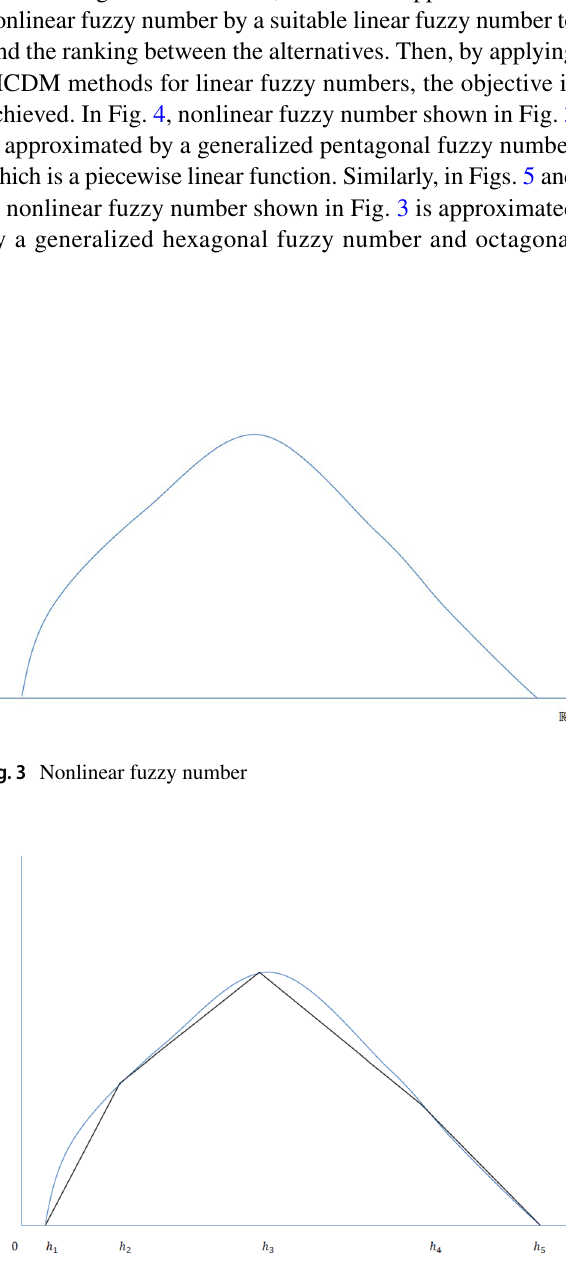
Fig. 2 Generalized hexagonal fuzzy number